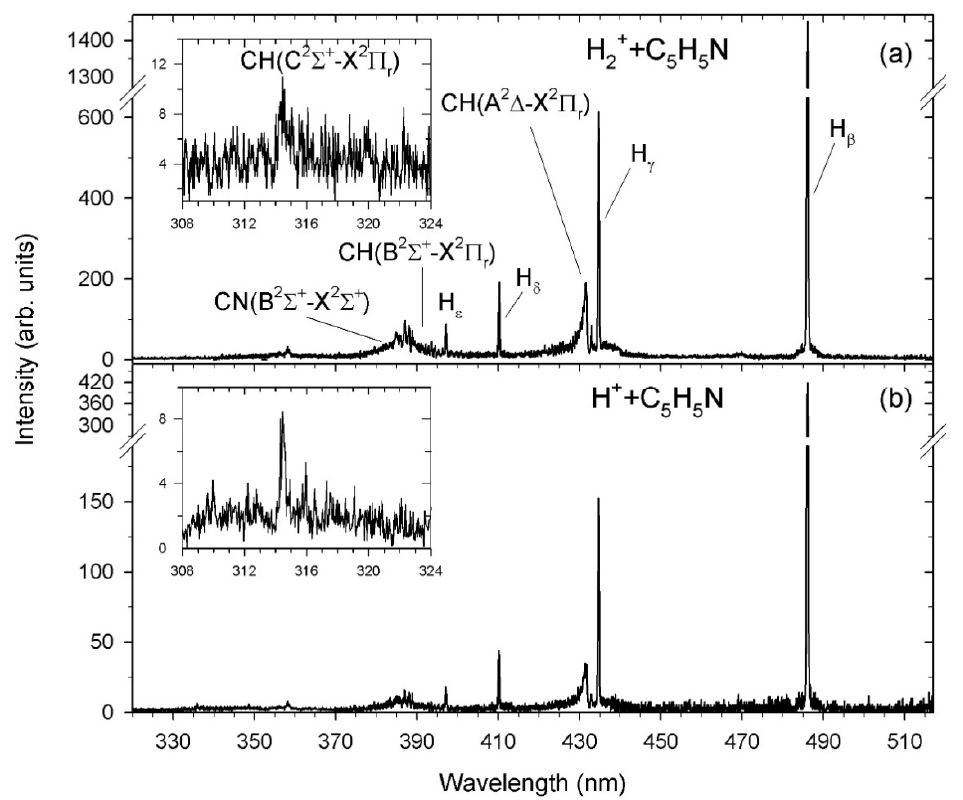
Figure 1. High-resolution optical fragmentation spectra measured for collisions ( a ) H 2+ + pyridine, ( b ) H + + pyridine. The spectra were not corrected for the wavelength dependence of the sensitivity of the optical detection system.